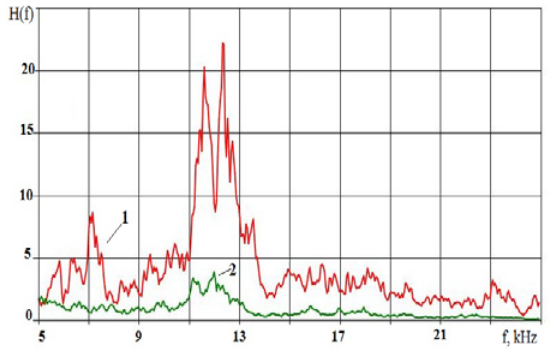
Fig. 6. AFR of EDM of cemented carbide at initial machining stage (graph.1) and before the TE breakage (graph. 2).